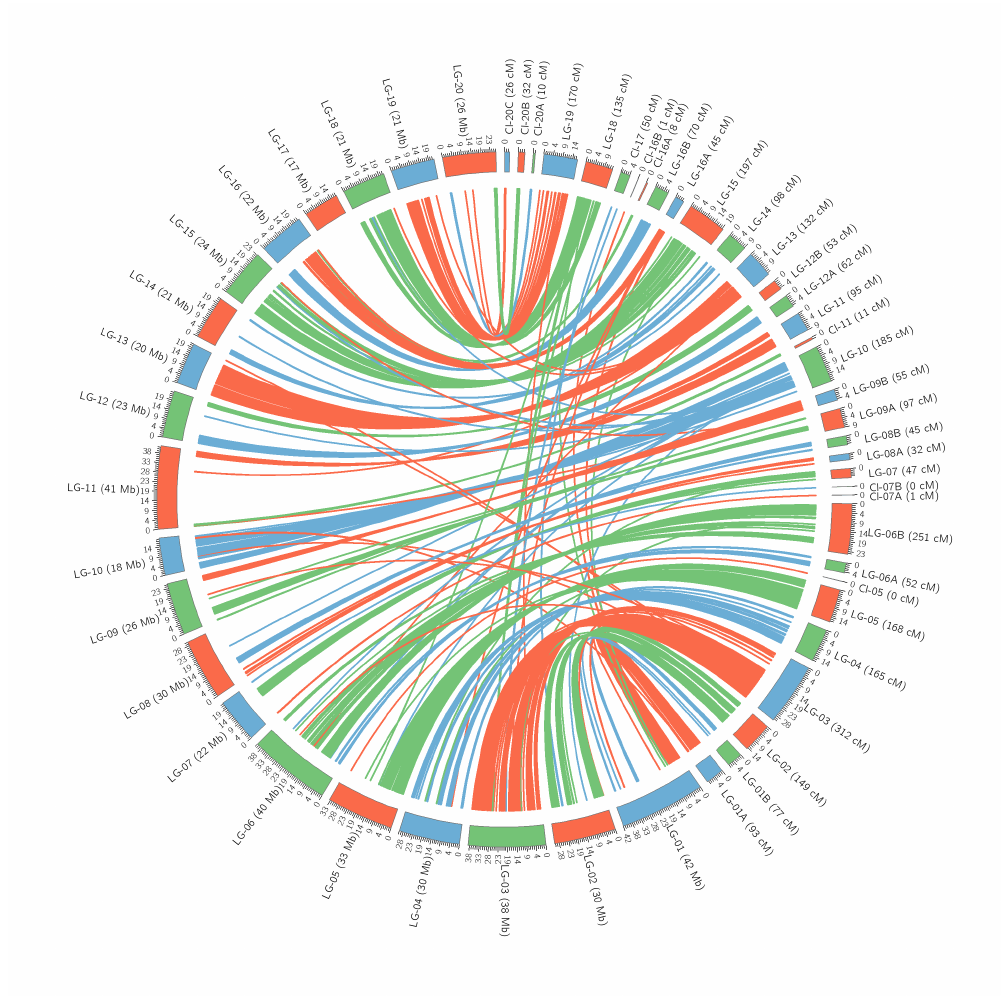
Figure 5. Circos plot, comparing obtained genetic linkage maps to Lupinus angustifolius reference genome